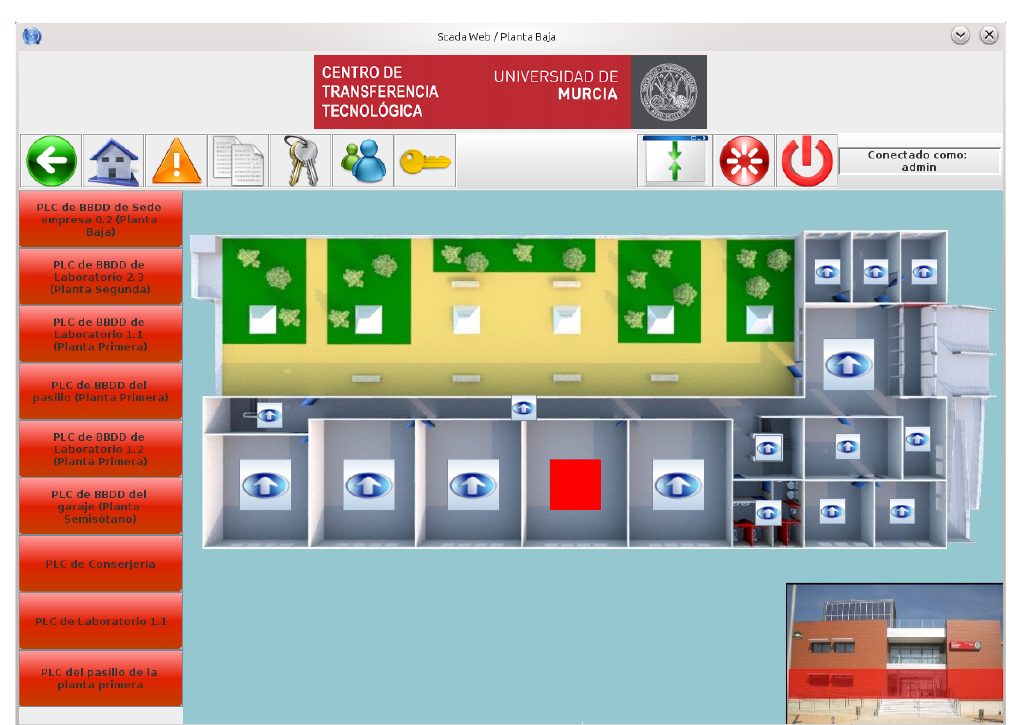
Figure 16. Use case 2: Test